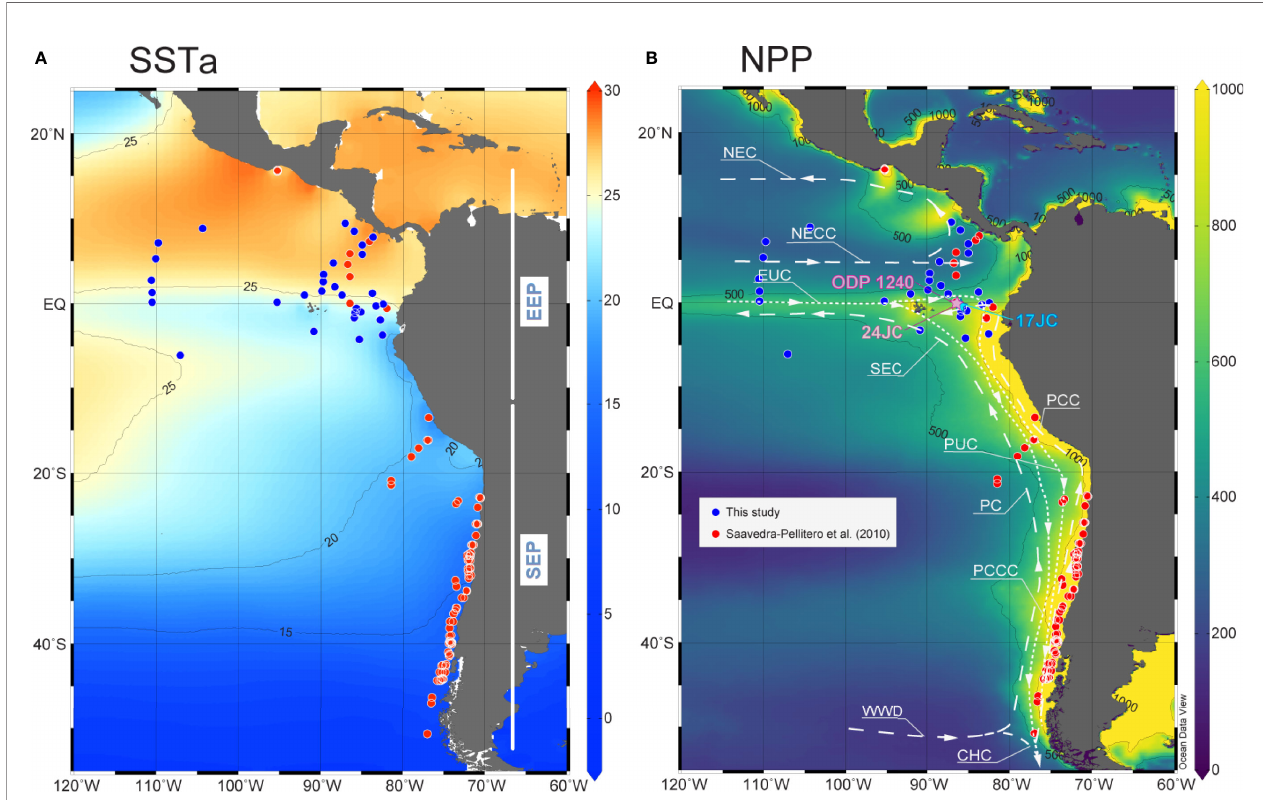
FIGURE 1 | Study area. (A) Annual sea surface temperature (SSTa, in °C) from the World Ocean Atlas 2013 (WOA13) (Locarnini et al., 2013). (B) Annual mean of net primary productivity (NPP, in mg C m -2 day -1 ) estimated using the VGPM algorithm (Behrenfeld and Falkowski, 1997). The red (Saavedra-Pellitero et al., 2010) and blue (present study) dots indicate location of the surface sediment samples with coccolithophore assemblage data. ODP Site 1240, ME0005-24JC (24JC in the map), MV1014-02-17JC (17JC in the map) and the major surface and subsurface currents in the eastern Paci fi c Ocean (Strub et al., 1998; Feldberg and Mix, 2002; Fiedler and Talley, 2006) are shown: WWD, West Wind Drift; PC, Peru Current; PCC, Peru-Chile Current; PCCC, Peru-Chile Countercurrent; PUC, Peru Undercurrent; SEC, South Equatorial Current; EUC, Equatorial Undercurrent; NECC, North Equatorial Countercurrent and NEC, North Equatorial